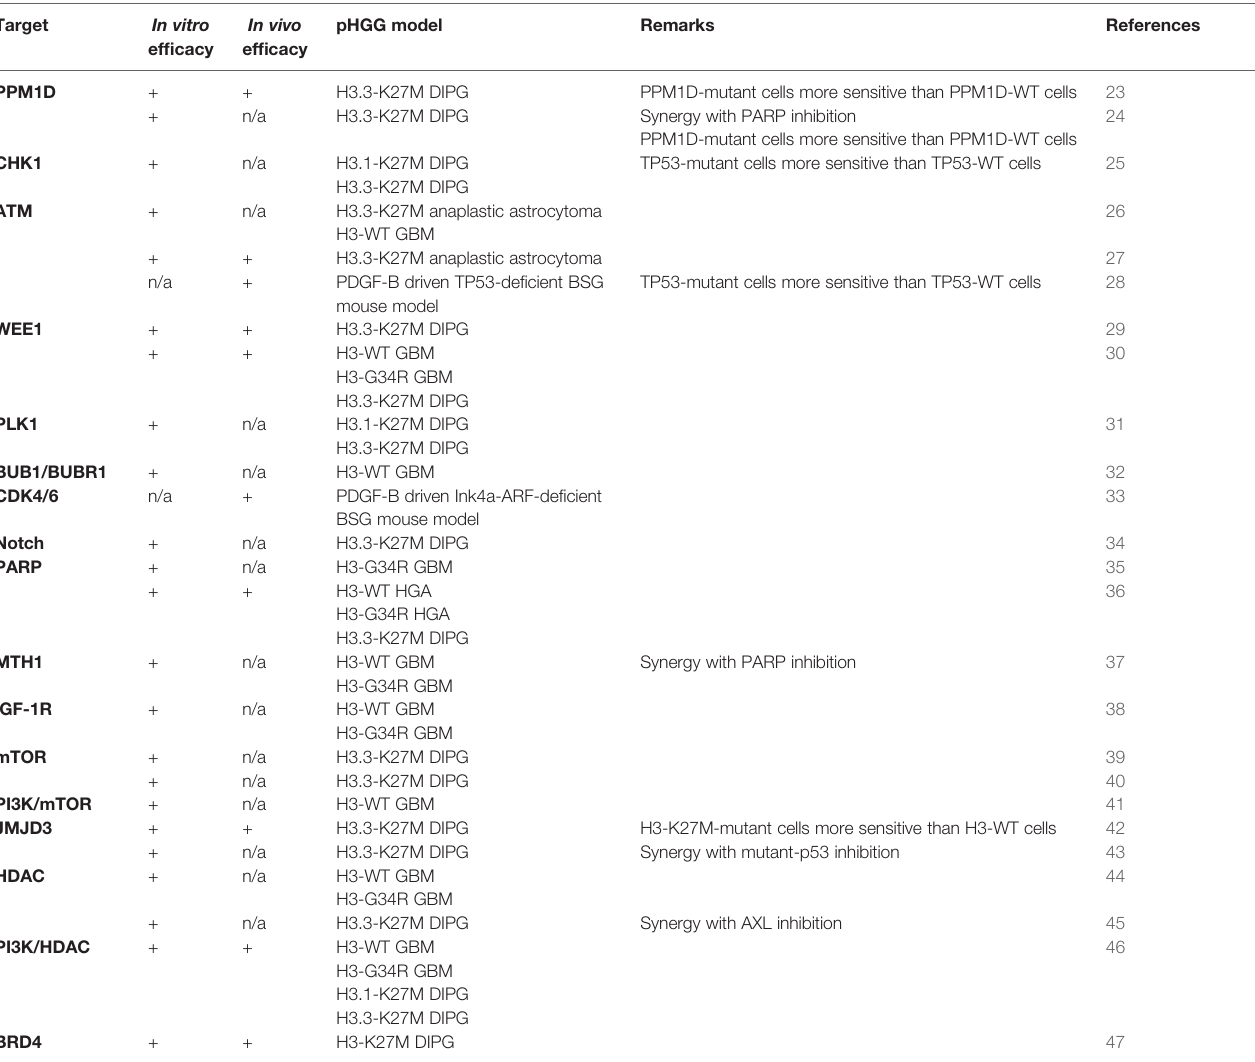
TABLE 1 | Overview preclinical radiosensitization studies addressed in this review.